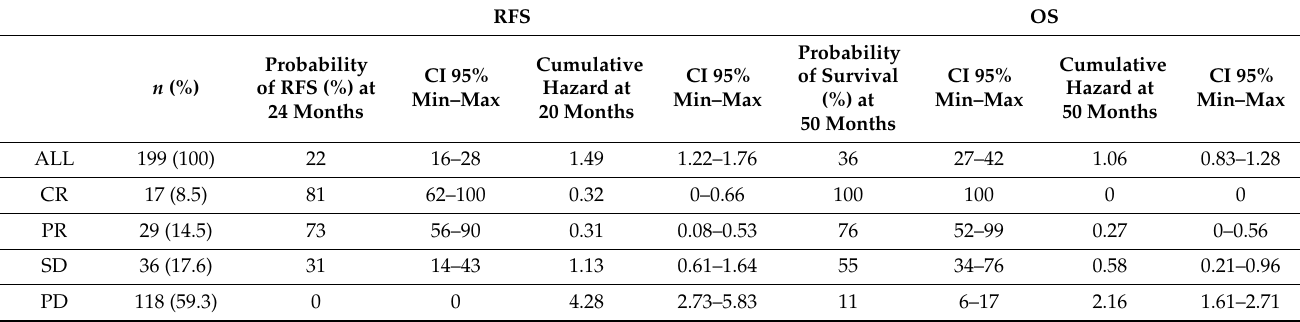
Table 3. RFS and OS analysis of naïve cohort. Probability of relapse free survival and probability of survival after immunotherapy received at inclusion at the